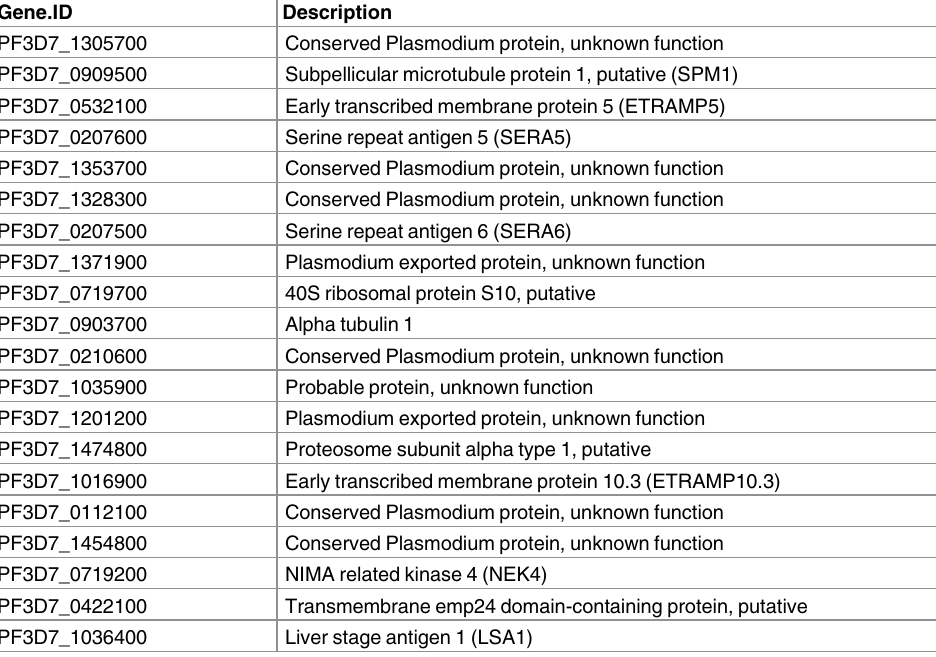
Table 3. IgM: Top 20 P . falciparum antigens by magnitude recognized by patient sera.